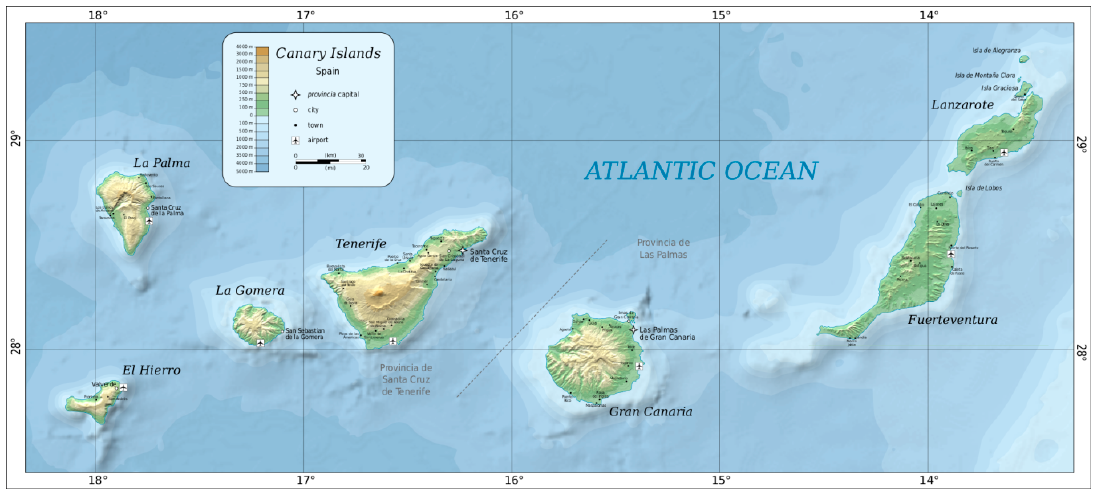
Figure 2. Map of the Canary Islands. Author: Oona Räisänen (Mysid) [Public Domain].